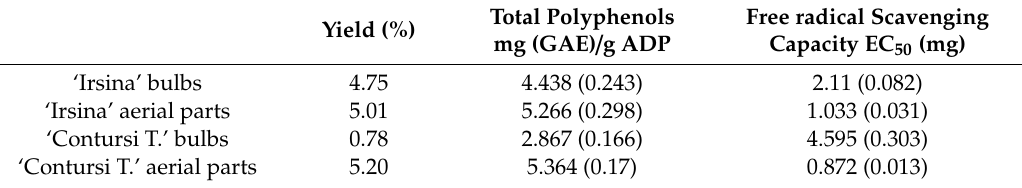
Table 1. The percent yield on fresh weight basis, amount of total polyphenols (as mg GAE / g of air-dried product) and the free radical DPPH scavenging capacity exhibited by the extracts of bulbs and aerial parts of A. ampeloprasum var. holmense ‘Irsina’ and ‘Contursi T.’ landraces. The results are the mean ( ± standard deviation) of three independent